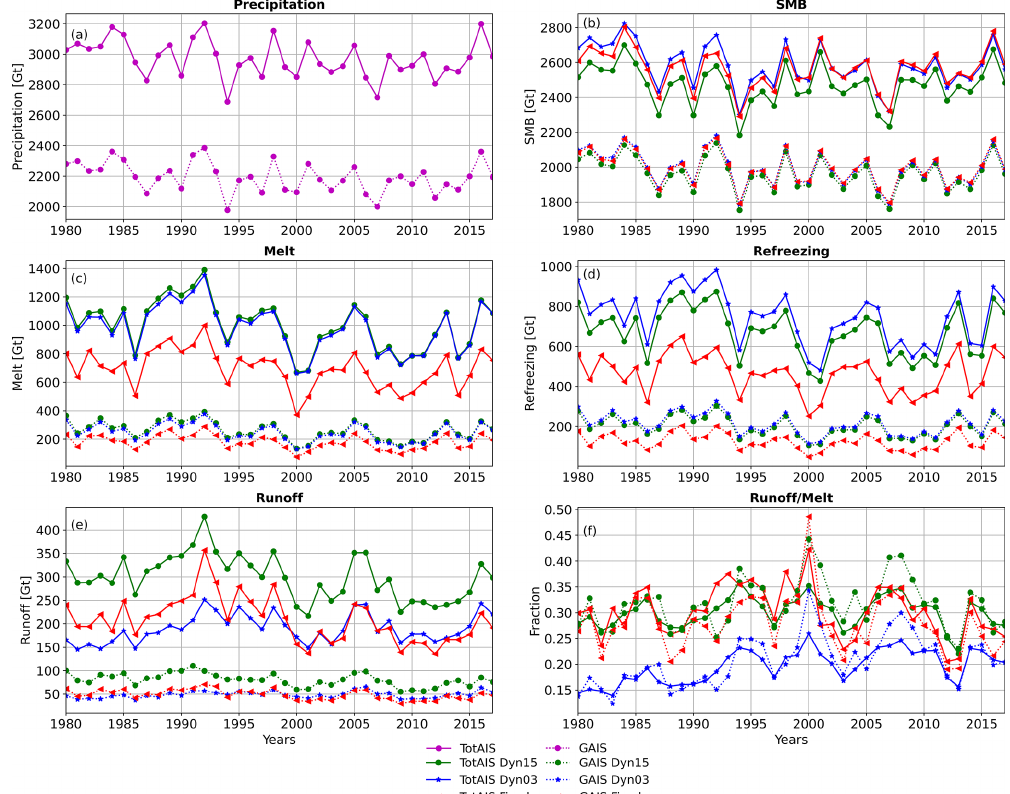
Figure 2. Integrated precipitation (a) , SMB (b) , melt (c) , refreezing (d) , and runoff (e) all in Gtyr − 1 . Panel (f) shows the runoff to melt fraction. For the three model simulations, for the entire AIS with ice shelves (ToAIS), and for the GAIS. Note different values on the y